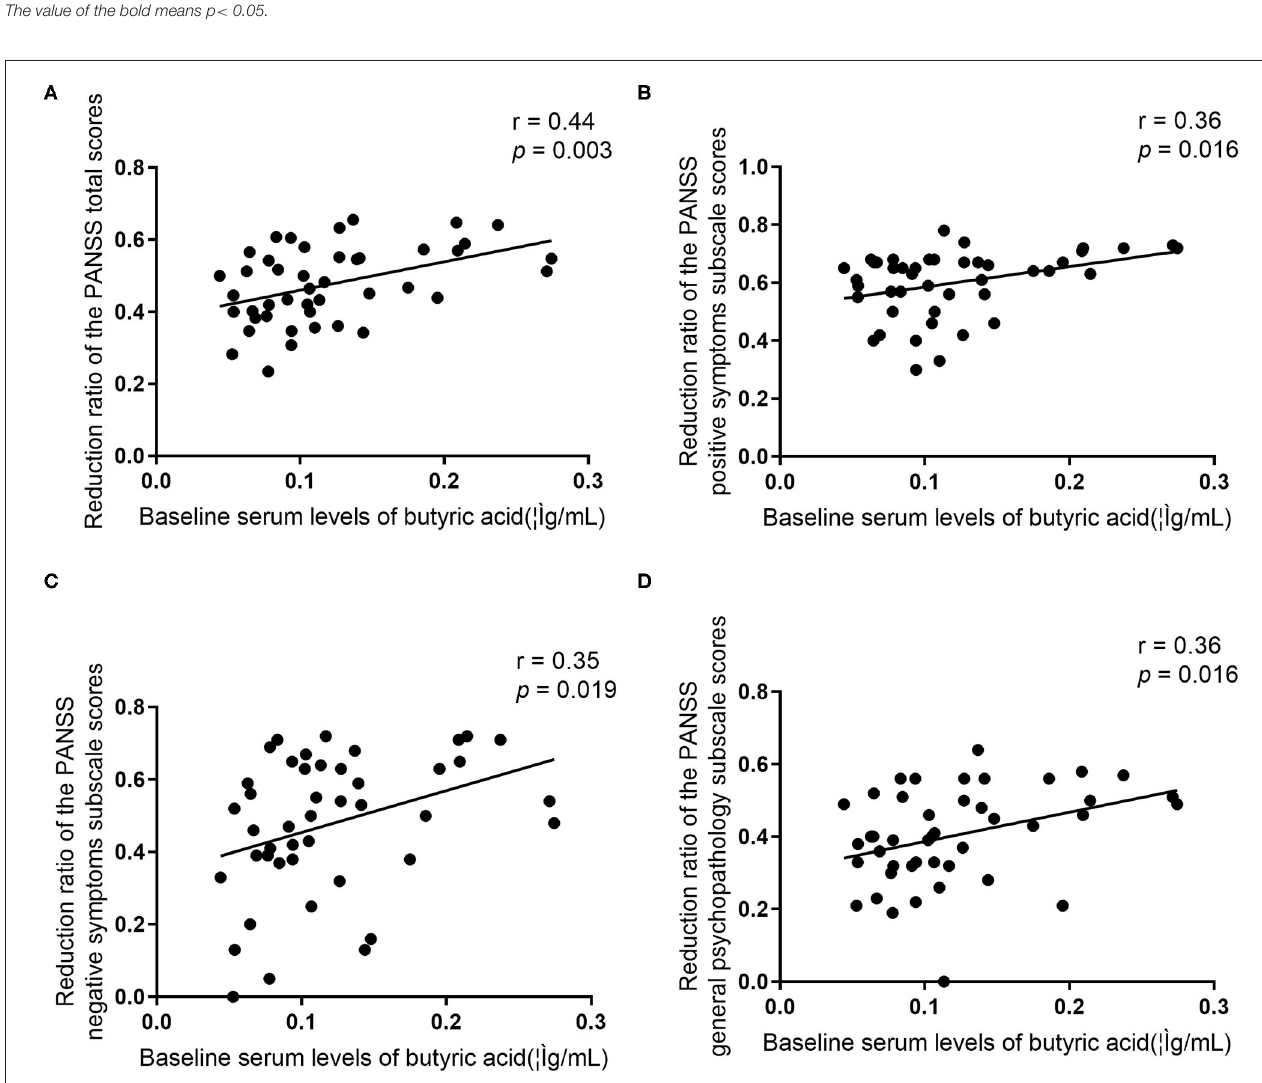
FIGURE 2 | ( A–D ) Relationships between the reduction of the PANSS total scores or subscale scores and the increase in serum levels of butyric acid in patients.